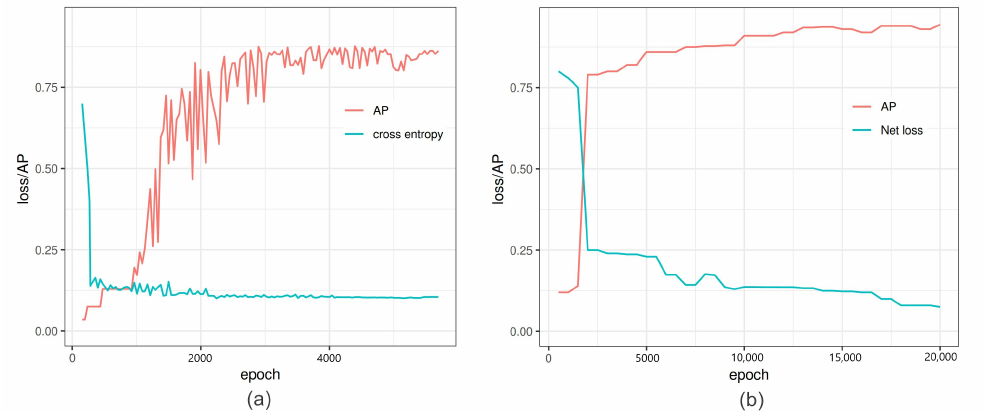
Figure 3. Comparison of performance of Faster-RCNN vs. YOLOv3: ( a ) Faster-RCNN in-training loss and average precision (AP) versus iterations of Faster-RCNN. At 6000 iterations, the binary cross entropy loss is minimized with high AP, and further training increases the loss and AP altogether. ( b ) YOLOv3 in-training binary cross entropy loss and average precision versus the epoch